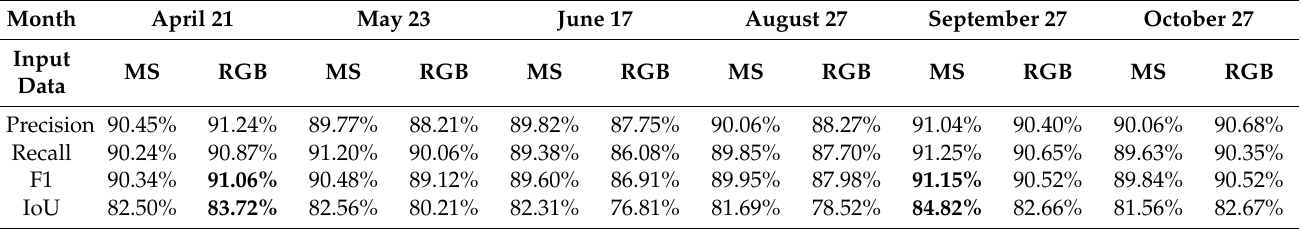
Table 4. Faxon fir mapping model accuracies in different months. For the multispectral (MS) and RGB imagery, the highest intersection over union (IoU) and F1 score (F1) are highlighted in